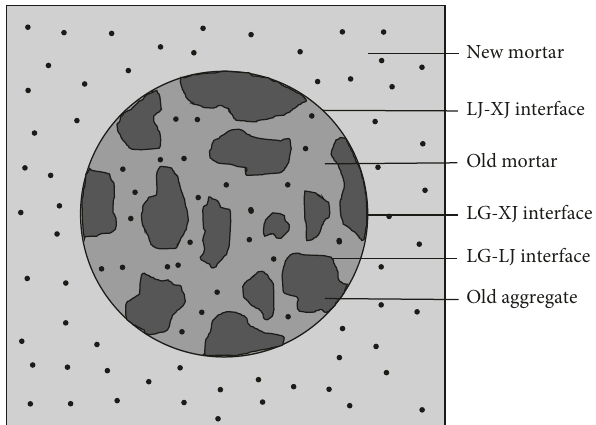
Figure 2: Section of a waste concrete specimen with a core